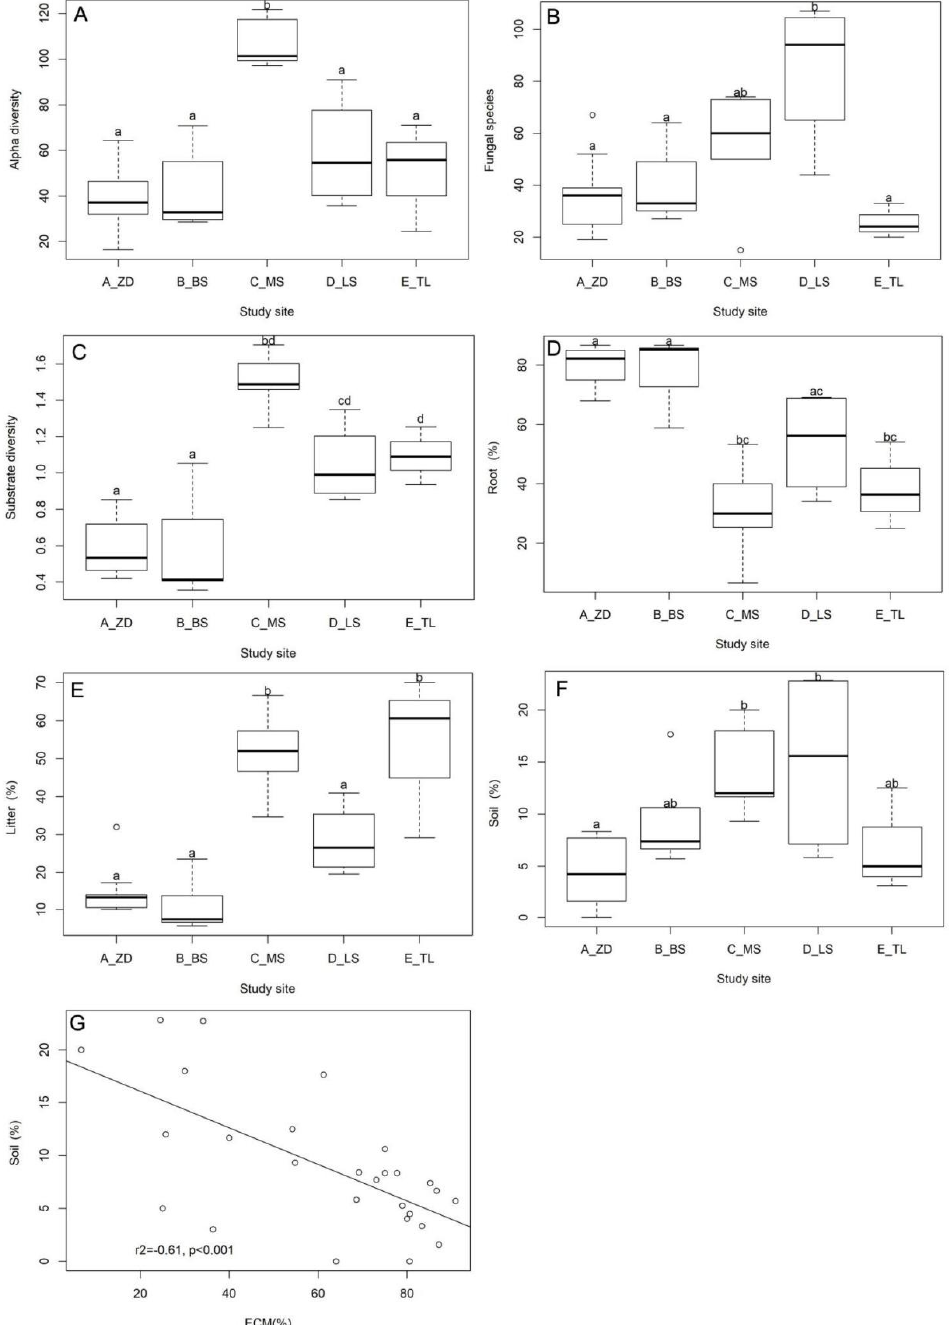
Figure 4. Macrofungal taxonomic diversity ( A ), species richness ( B ), and substrate utilization diversity ( C ) for macrofungal species collected in the GMS. For each site, we calculated the taxonomic diversity based on morphological characteristics and calculated the substrate diversity based on the macrofungi count in each of the 15 substrates (Table S1). Relative abundance of macrofungal species in each substrate category across all sampling sites ( D – F ). The correlation between soil macrofungi and ectomycorrhizal fungi was also calculated ( G ). ZD: Zhongdian, BS: Baoshan, MS: Mengsong, LS: Laos, TL: Thailand. The lower-case letters indicate statistical significance.